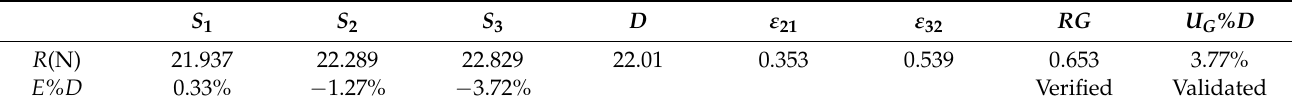
Table 3. VV result for the ship total resistance R with the original sonar